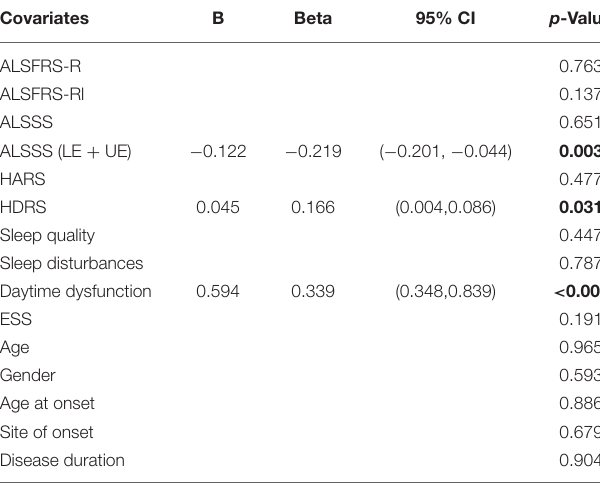
TABLE 5 | Factors associated with the intensity of fatigue in the multiple linear regression